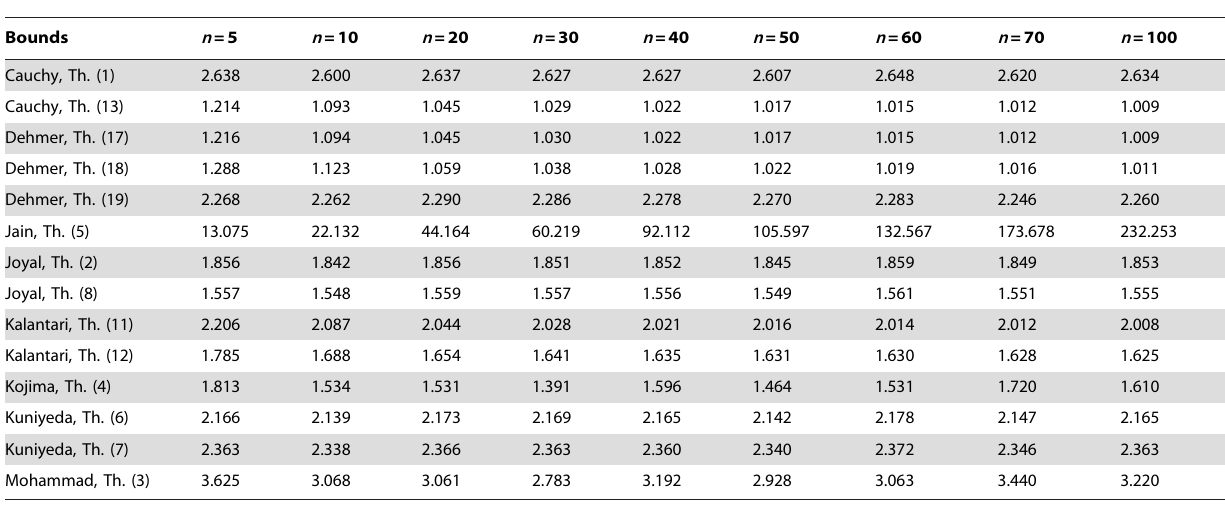
Table 6. Mean bounds values for polynomials P i [ C 6 .